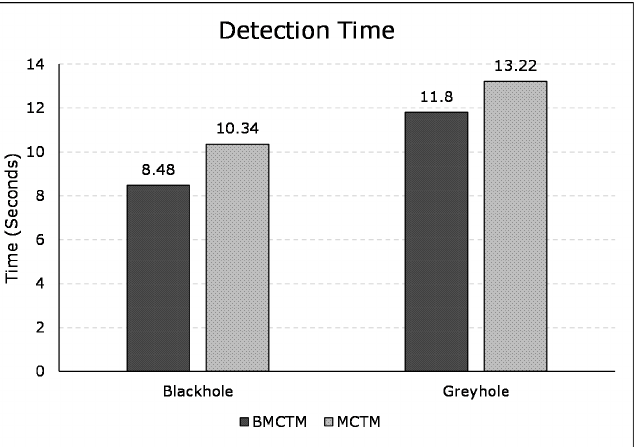
Figure 8. Malicious node detection time of BMCTM and MCTM in blackhole and greyhole attack sce-